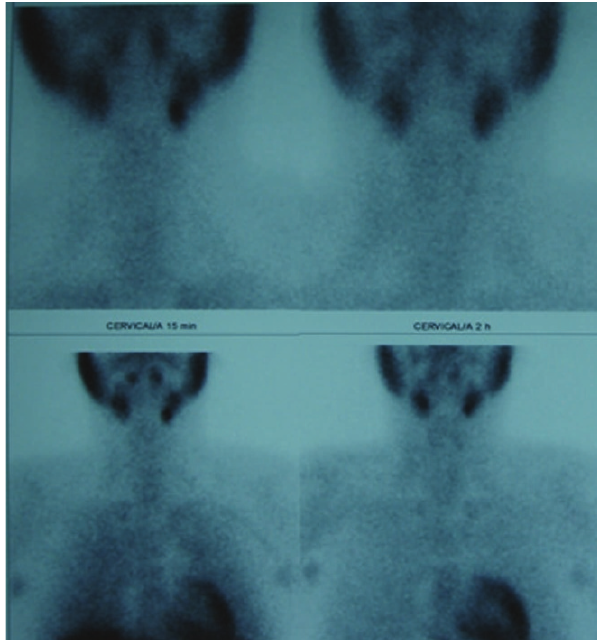
Figure 6 - Sestamibi scintigraphy after two previous neck interventions in a patient with hyperparathyroidism/multiple endocrine neoplasia type 1 who had been treated initially at another hospital. There was a focal radiopharmacological concentration close to the left submandibular gland due to an undescended left inferior parathyroid.